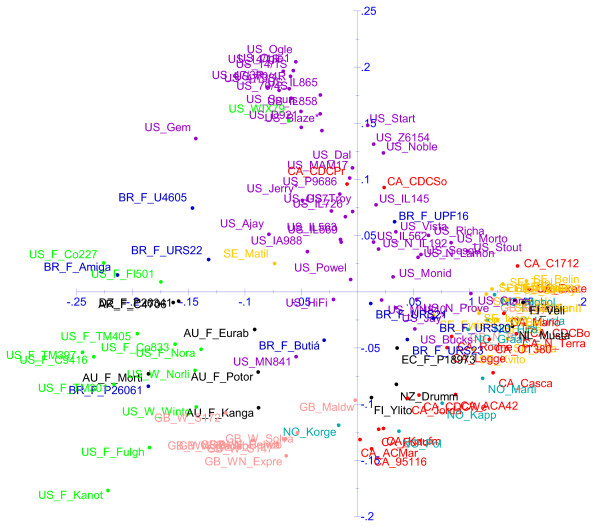
Principle coordinate analysis (PCA). Plot of PCA axes 1 and 2 based on Manhattan distance calculations for 134 oat varieties using 1295 non-redundant DArT marker loci. Oat varieties are identified by truncated entry names, which are preceded by two-letter codes indicating country of origin, and by additional codes if they are winter-types (W), fall-sown but winter grown (F), or naked (N). See Additional file 1 for full entry names and country of origin codes. Selected counties of origin are coloured blue (Brazil), red (Canada), pink (Great Britain), light-blue (Norway), yellow (Sweden), purple (USA), or green (USA-Fall/Winter).